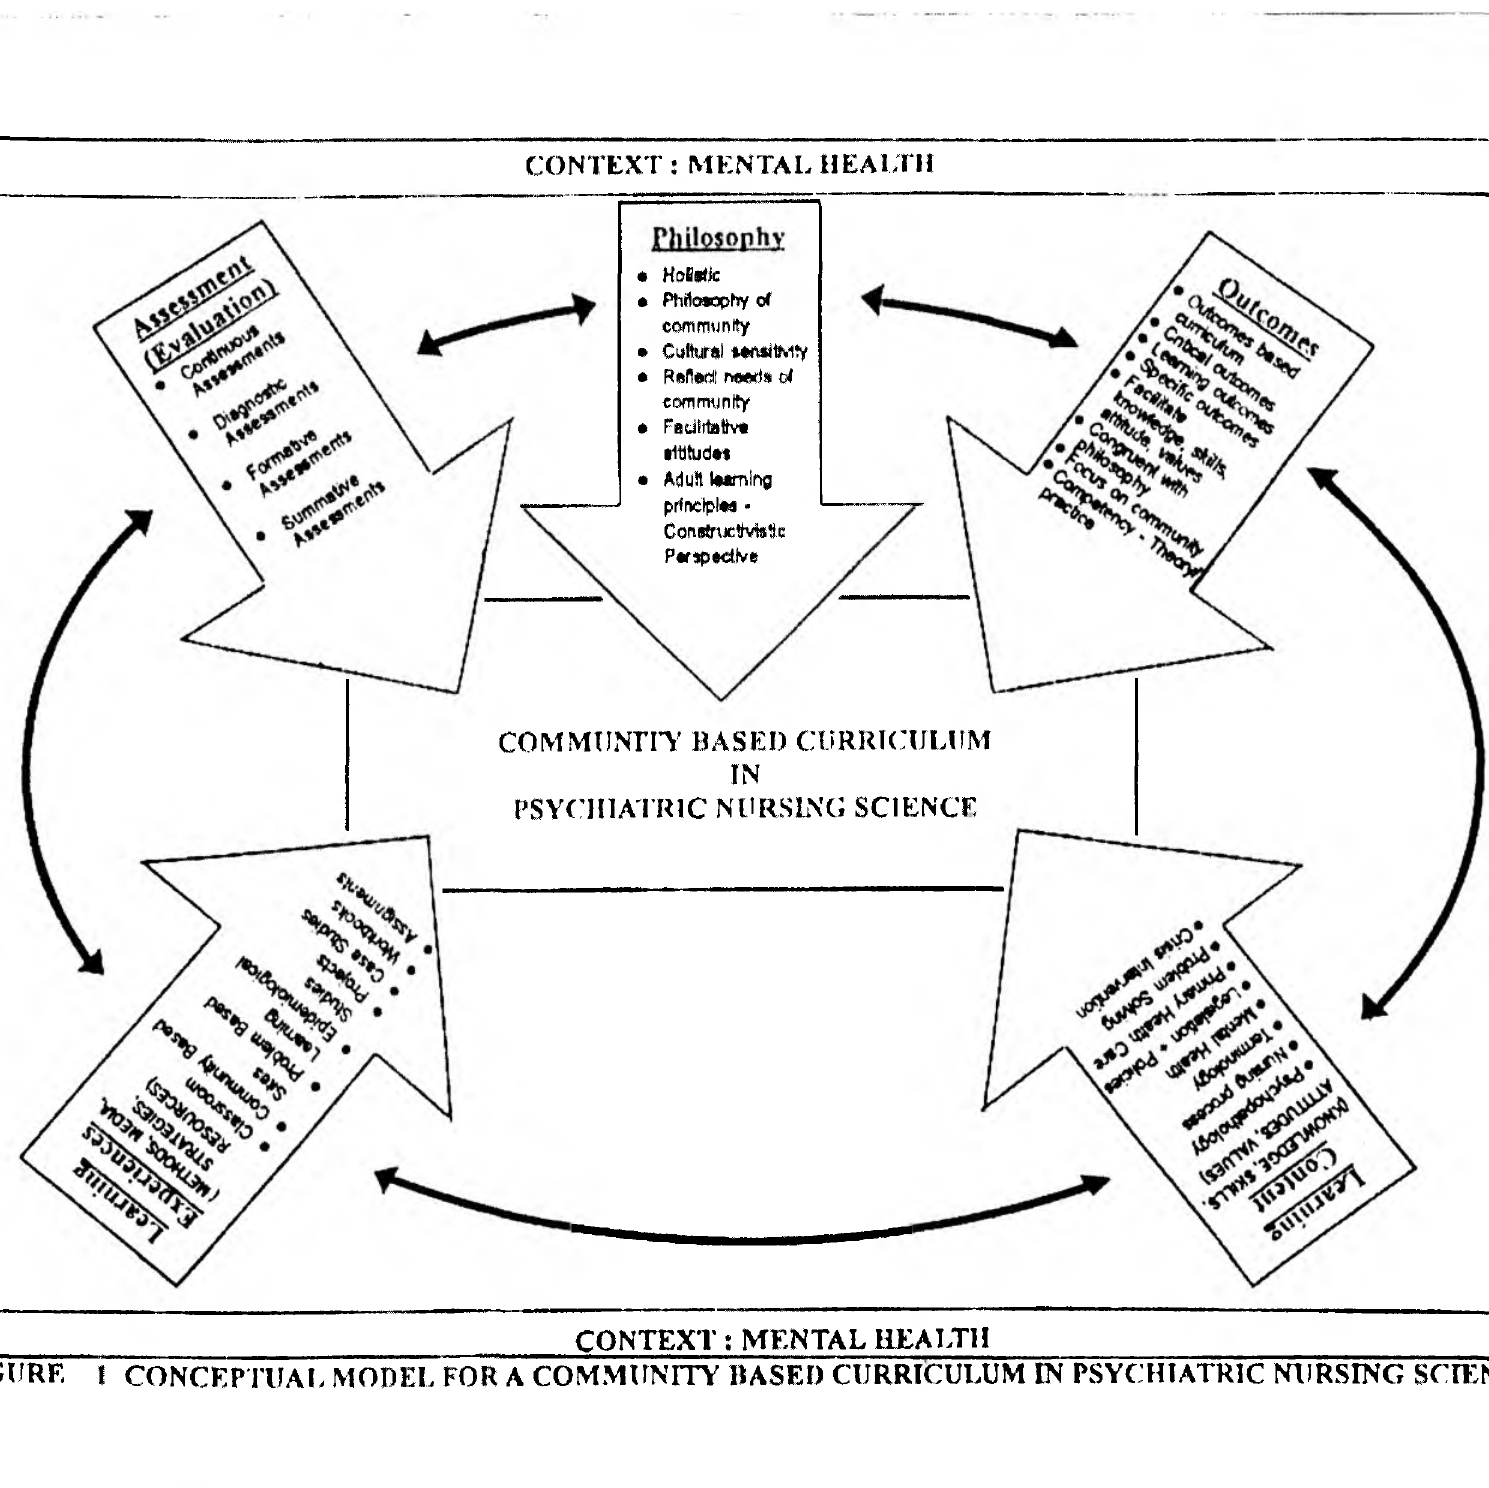
I CONCEPTUAL MODEL FOR A COMMUNITY BASED CURRICULUM IN PSYCHIATRIC NURSING